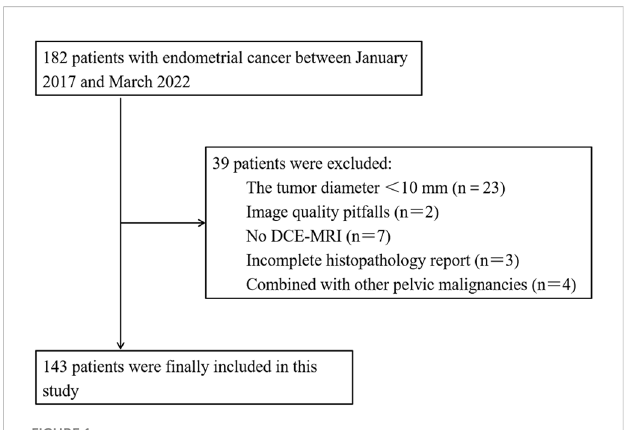
FIGURE 1 Flowchart of included and excluded patients with endometrial